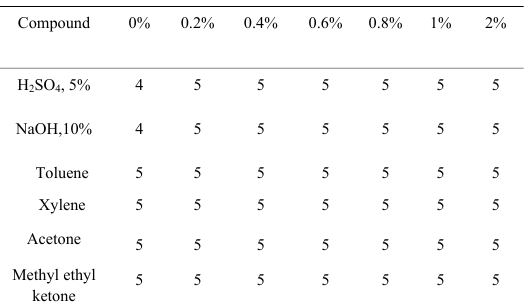
Table 2: Chemical resistance of polyurethane/silicon oxide nano- composite coatings (23 ∘ C, 7